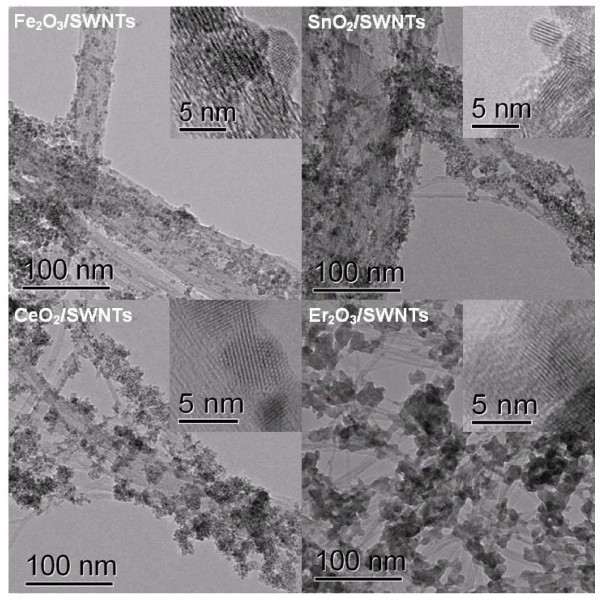
TEM images of various metal oxide NPs of Fe2O3, SnO2, CeO2, and Er2O3 on SWNTs.